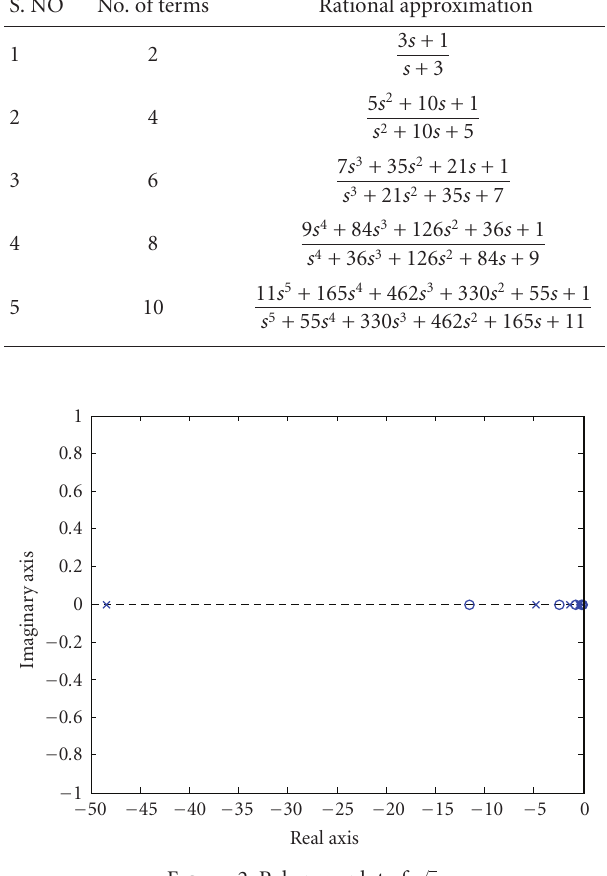
Table 1: Rational approximations for